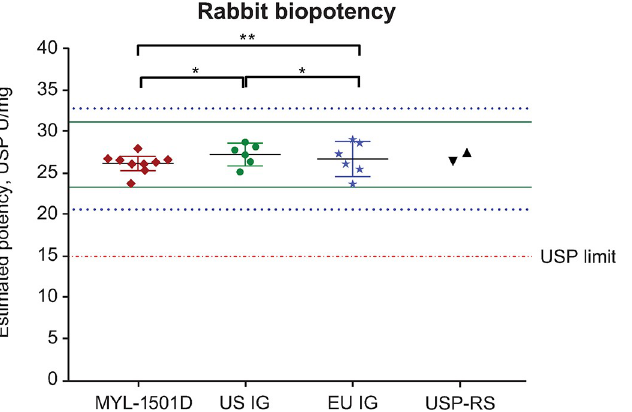
Fig 17. Scatter plot distribution of in-vivo rabbit bioassay activity for MYL-1501D, US-, and EU-licensed insulin glargine. Nine lots of MYL-1501D and 6 lots each of US- and EU-licensed insulin glargine were analyzed, and data are expressed as mean ± 95% CI. Mean ± 3 SD range derived from innovator product is presented as solid green line for US-licensed insulin glargine and dotted blue line for EU-licensed insulin glargine. � P < 0.05, �� P < 0.01, and ��� P < 0.001 in TOST/Equivalence test. Potency of the 2 USP reference standards (USP-RS) used in the study are presented as black symbols ( ▲ USP human insulin standard lot JOJ250, ▼ USP insulin glargine standard lot F009M0). Limit of the biopotency value, ie, � 15 USP units/mg, as per USP < 121 > is presented as red dotted line. TOST, Two One-Sided T- test; USP, US Pharmacopeia.